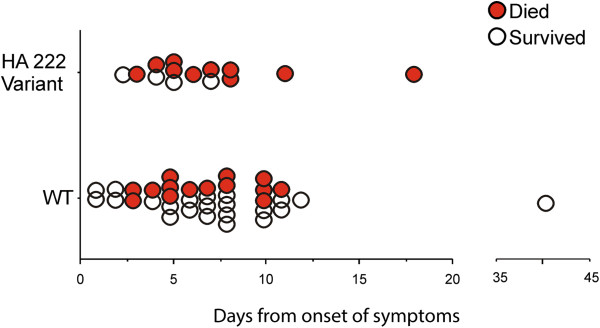
Time from onset of symptoms to sample time at the hospital, for patients with and without the D222 variants. WT: wild type (222D). There were no statistical differences (p = 0.4055).